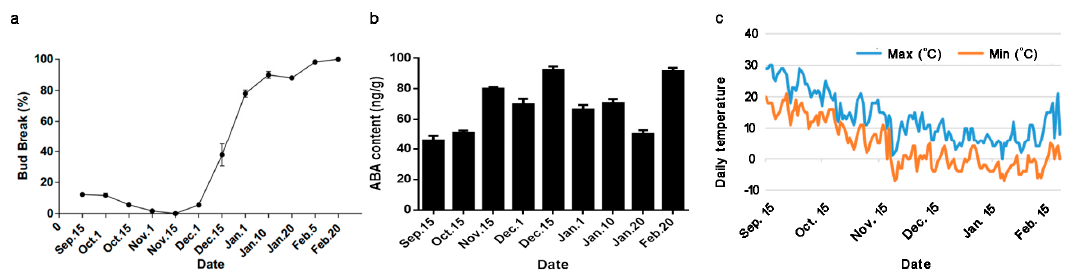
Figure 1. The change of abscisic acid (ABA) content during the endodormancy period. ( a ) Dormant shoots of field-grown “Suli” pear trees were collected from 15 September 2016 to 20 February 2017, then kept in water in a phytotron at day/night temperatures of 25 ± 1/22 ± 1 ◦ C, with a 12-h photoperiod of white light (320 µ mol photon m − 2 · s − 1 ), and 75% relative humidity. Percentage of bud breaks was assessed after 21 days using 12 shoots per sampling period. Each bar represents the mean ± SEM ( n = 3). ( b ) The concentration of ABA in pear flower buds at different dormant states. Each bar represents the mean ± SEM ( n = 3). ( c ) Daily maximum and minimum temperatures during 2016–2017.